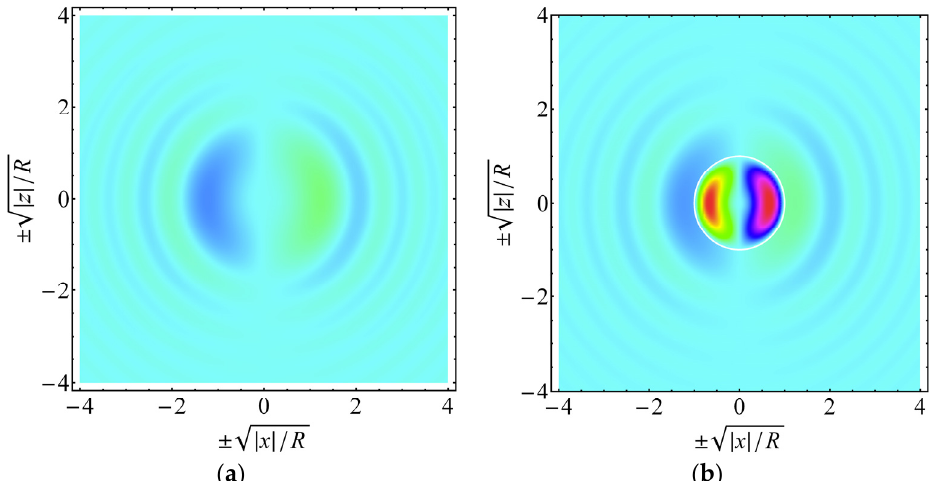
Figure 2. ( a ) Spatial distribution of the excitation field (12) at the frequency of the perfect nonradiating mode PTM 11 and ( b ) full field (10) in the presence of nanoparticle ( n = 1, k 0 R = 1.36687, ε = 12).